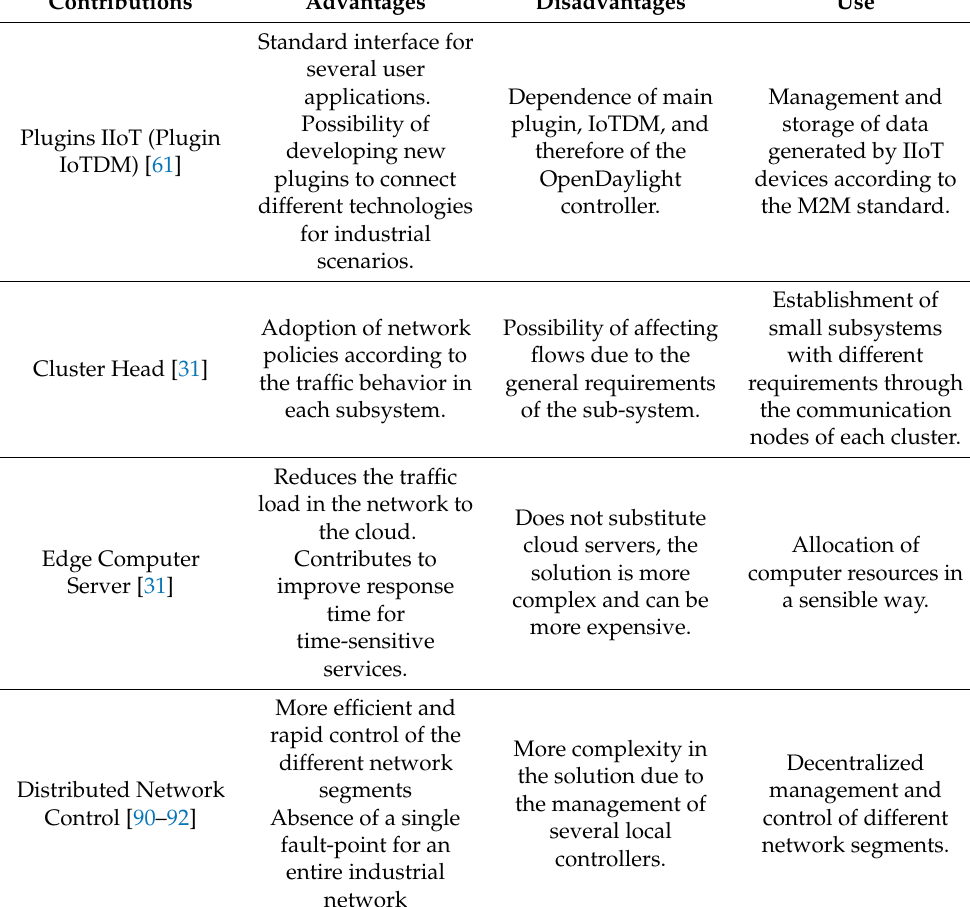
Table 2. Characteristics of different